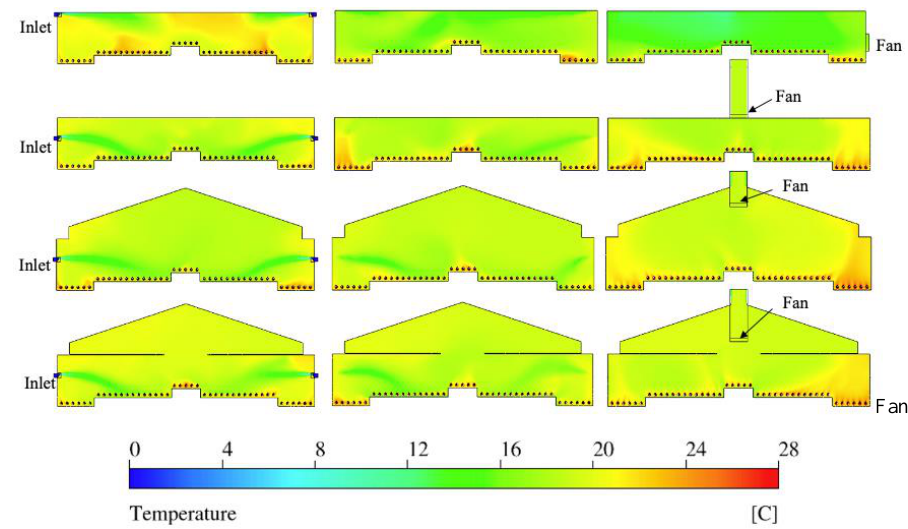
Figure 9. Indoor temperature contours of four models, from top to bottom rows: TISE, MISE, MICE, and MIAE at three reference planes (columns from left to right: Plane I, Plane N, and Plane F).